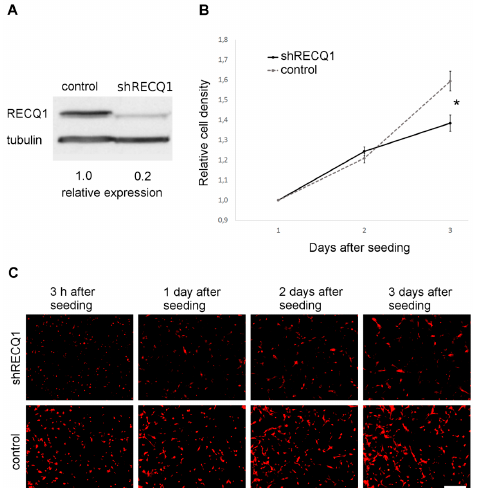
Figure 1. RECQ1 silencing in U87 DsRed cells and its effects on the increase in cell number in vitro. ( A ) The expression of RECQ1 helicase in U87 cells transfected with small hairpin RNA (shRNA) targeting RECQ1 (shRECQ1) and control cells as quantified by Western blot analysis. The relative expression of RECQ1 in RECQ1-silenced cells was 20% of its expression in the control cells; ( B ) Changes in cell density of cultured RECQ1-silenced (shRECQ1) and control U87 DsRed cells as determined by measurement of DsRed fluorescence intensity. The increase in the number of RECQ1-silenced cells was reduced relative to the control cells on day 3 after seeding. Means ± standard error (SE) are shown; ( C ) Sequential images of U87 DsRed cells in adherent cultures, captured at 3 h after seeding and at the same time during the following three days. Scale bar: 400 µm. Significance: * = p ≤ 0.05.